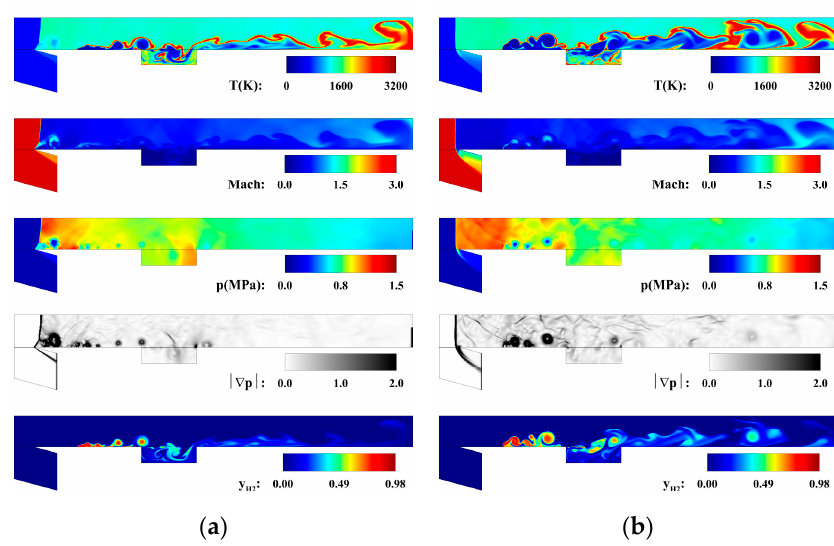
Figure 4. Instantaneous result for straight-channel combustor with cavity based on the injection pressures: ( a ) 0.75 MPa and ( b ) 1.00 MPa.